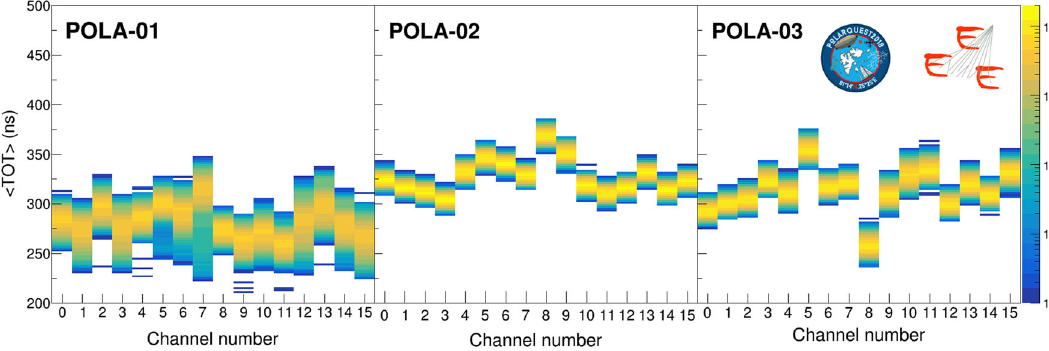
Fig. 13 TOT distributions averaged over the full period of data taking measured with POLA-01, POLA-02 and